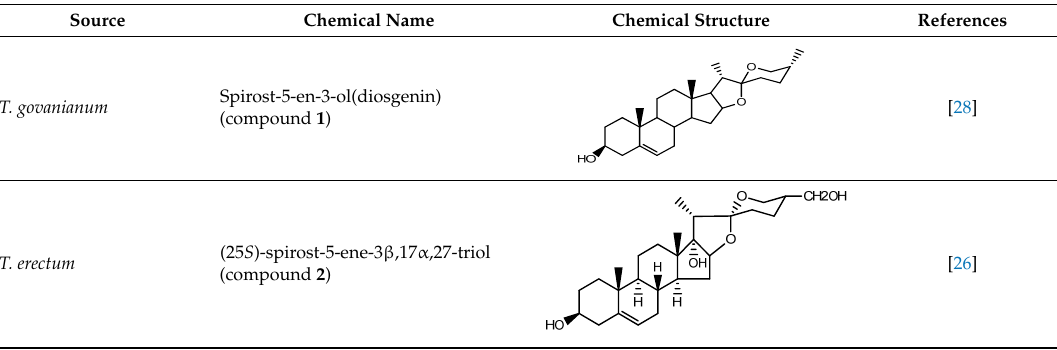
Table 2. List of phytochemicals isolated from genus Trillium .